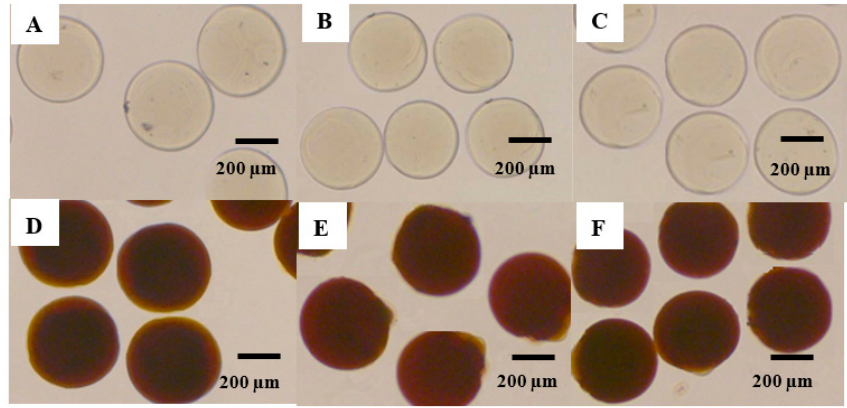
Figure 3. Optical microscopy images of the chitosan composite particles. The ( A )–( C ) images show the VBL-loaded chitosan particles. The ( D )–( F ) images show the VBL-loaded SPIO NPs–chitosan composite particles.